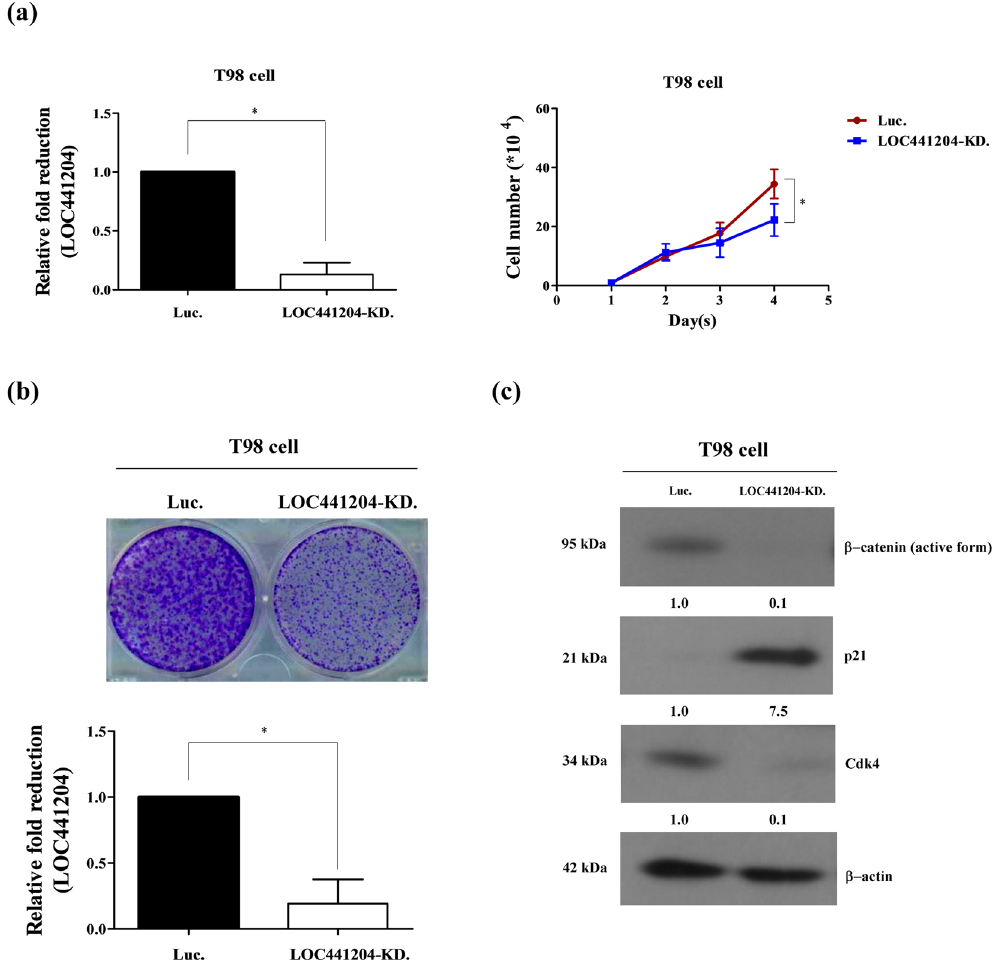
Figure 4. LOC441204 depletion suppresses T98 cell proliferation. ( a ) Right panel : The proliferation ability of T98 was analyzed under LOC441204-depleted (LOC441204-KD.) and control (Luc.) conditions. Left panel : Quantification of LOC441204 expression. ( b ) Colony assay of the T98 cell line under similar conditions. ( c ) Western blot analysis of β -catenin, p21 and cdk4 expression levels in cell lines. Differences were analyzed using the Kruskal–Wallis test ( * P <